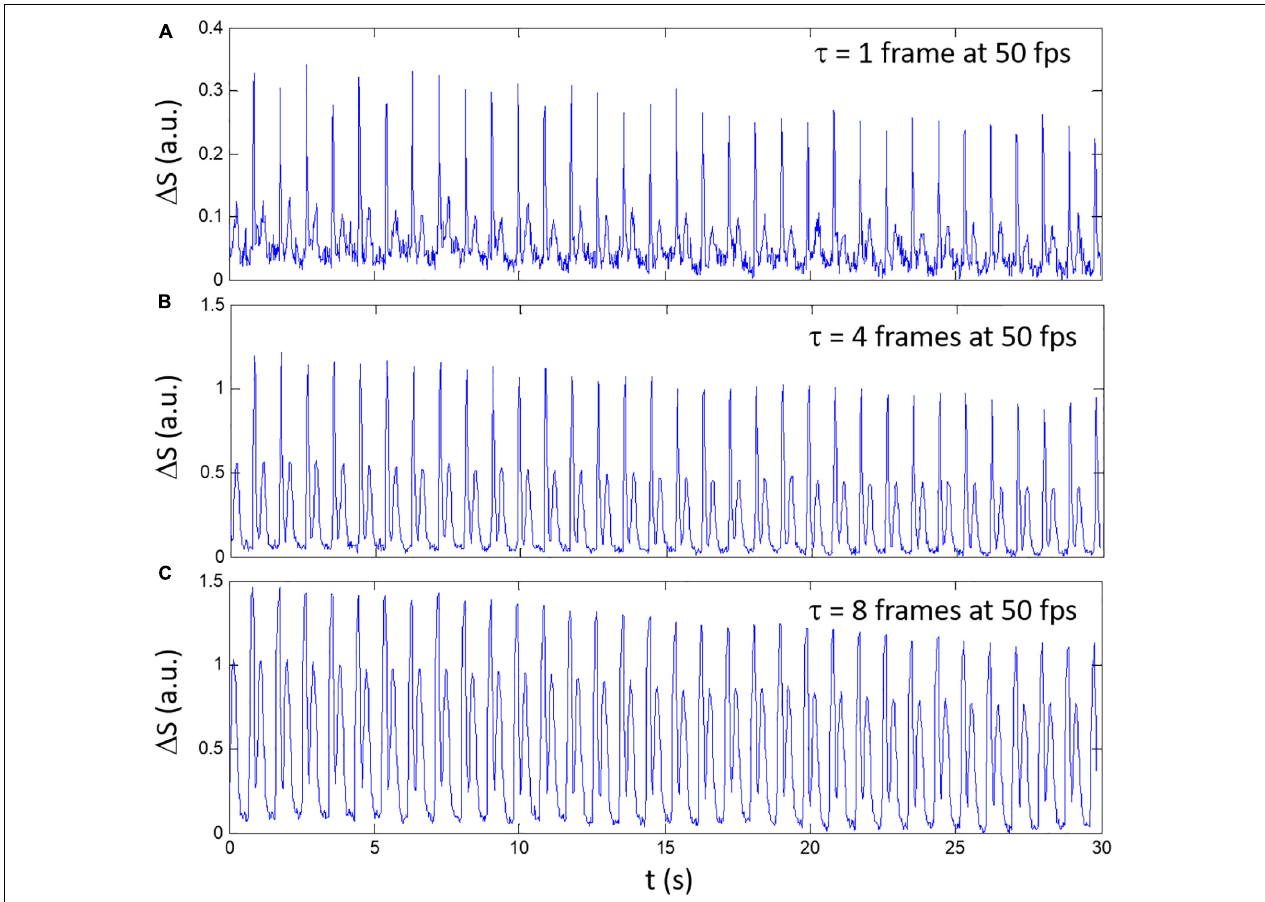
FIGURE 1 | An example of composite signals (cid:49) S obtained with different delay between frames for a spontaneously beating sample. (A) τ = 1 frame, (B) τ = 4 frames, and (C) τ = 8 frames. The video was recorded at 50